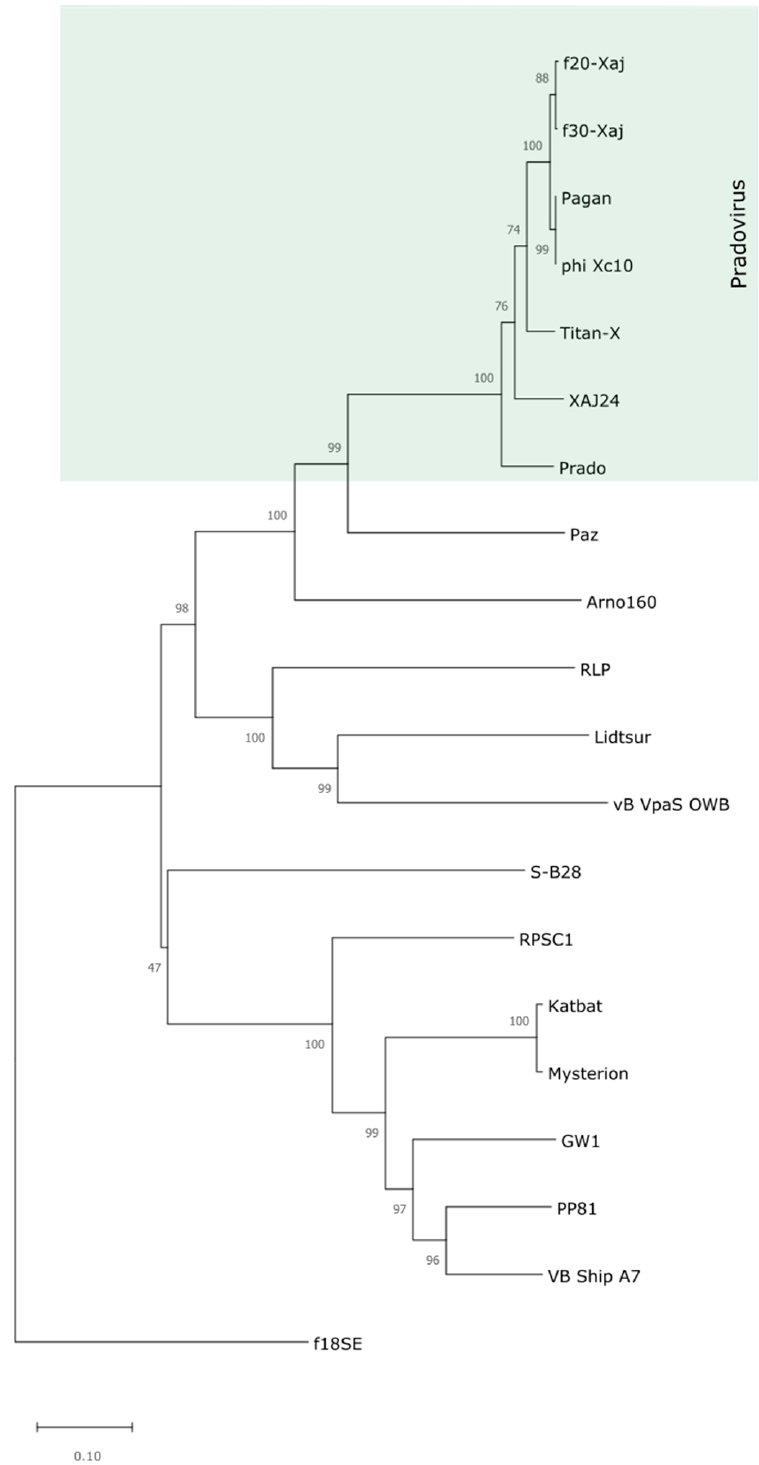
Figure 3. Phylogenetic tree of Pradovirus genus of bacteriophages made with whole-genome-based methodology through MEGAX software [39] and compared with other bacterial phytopathogen phages. The evolutionary history of f 20-Xaj and f 30-Xaj was inferred using the Neighbor-Joining method. The percentage of replicate trees in which the associated taxa clustered together in the bootstrap test (1000 replicates) are shown next to the branches [42].